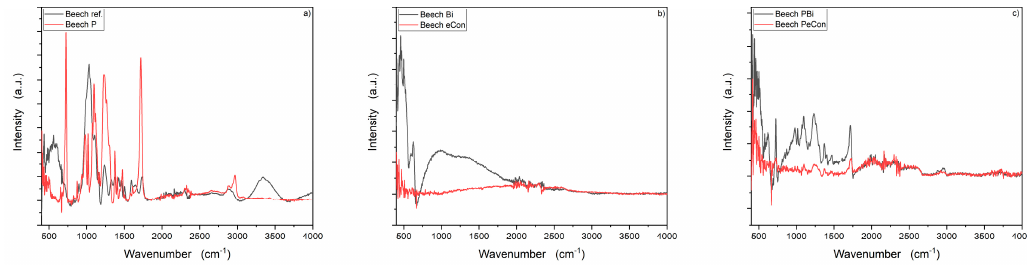
Figure 5. Coated and uncoated European beech with ( a ) reference and polyester coating, ( b ) Bi and eCon coating and ( c ) PBi and PeCon ( n = 3).